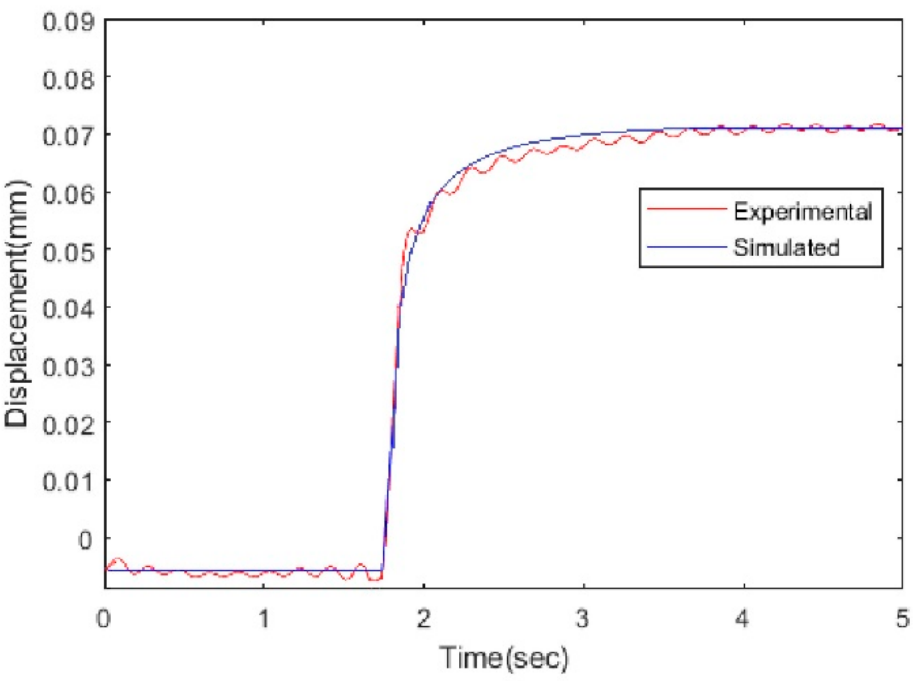
Figure 23. Step response of conductive material with VCA.